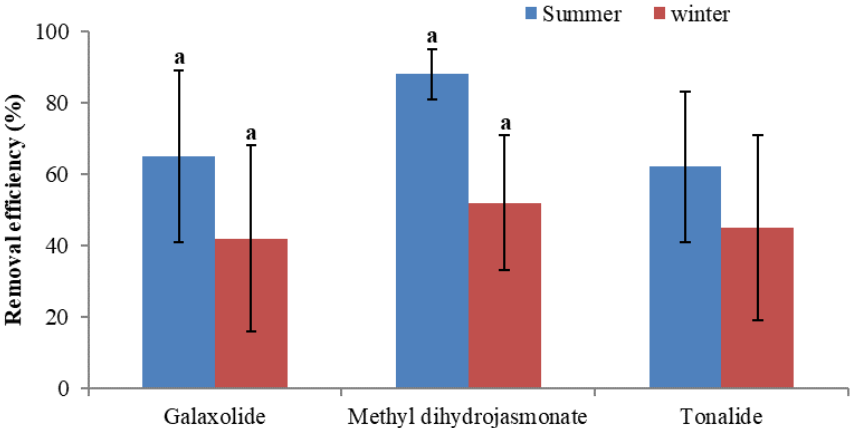
Figure 4. The removal e ffi ciency (mean and standard deviation) of PCPs with di ff erent types of CWs in di ff erent seasons. Note: Galaxolide and methyl dihydrojasmonate: “a” shows the significant di ff erence in the removal e ffi ciency during summer and winter at α = 0.05 ( p < 0.05). The number of observations for studied PCPs for seasonal e ff ect is given in Table S8 (Supplementary Materials).